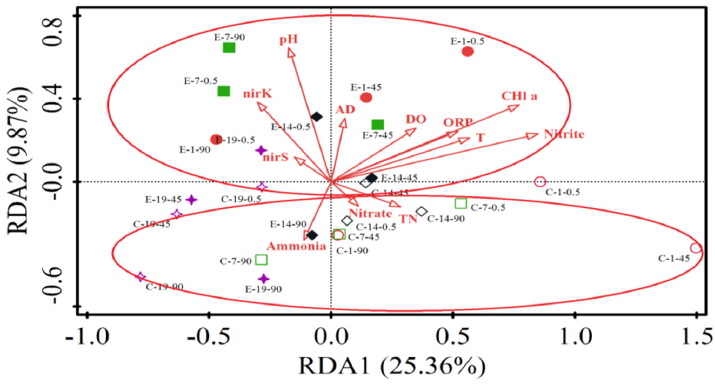
Figure 8. Redundancy analysis of water bacterial communities in the enhanced and control areas.